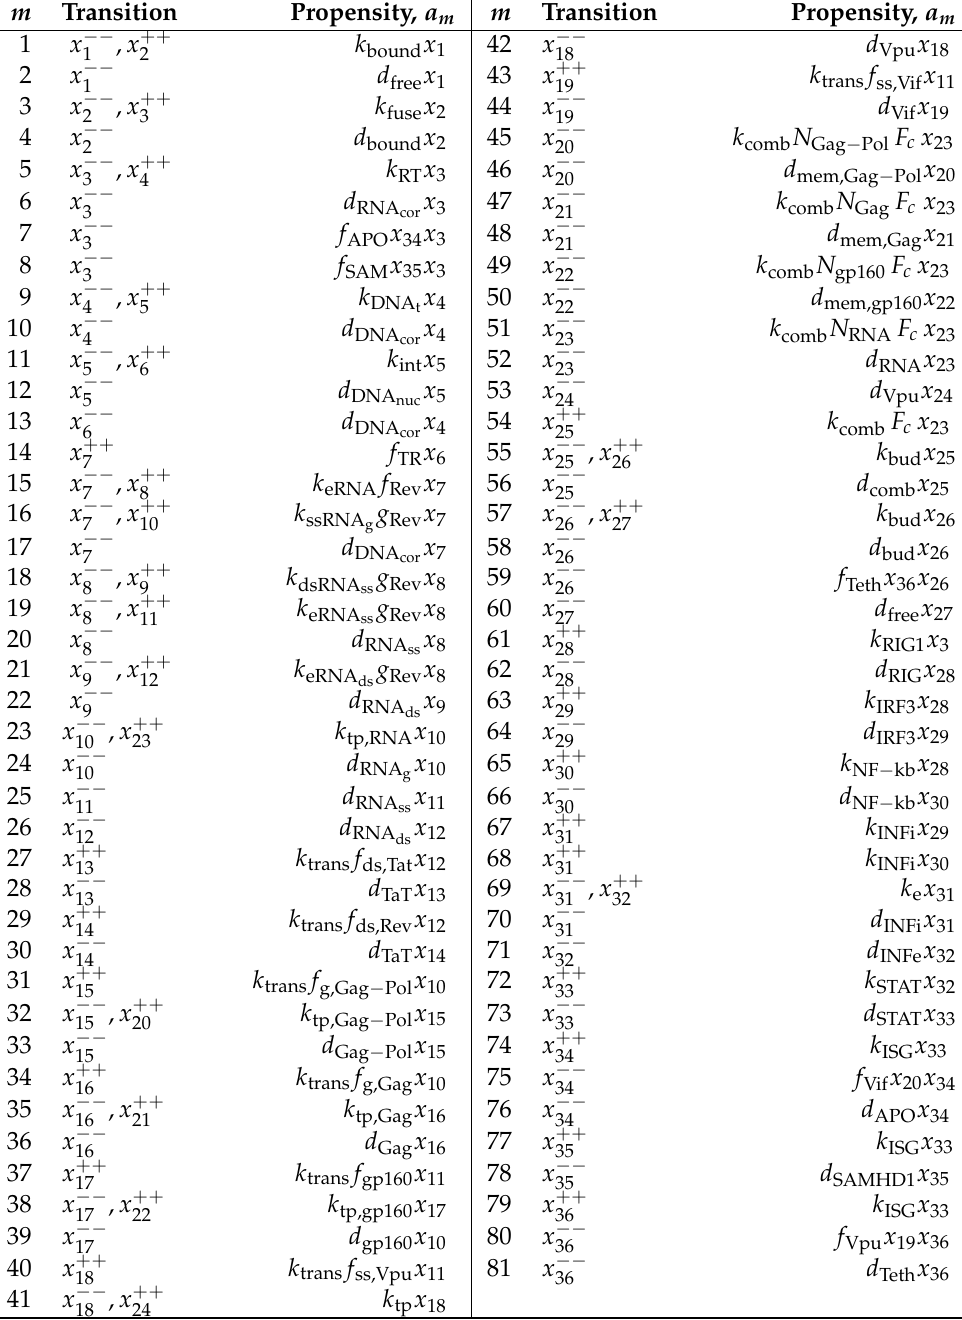
Table 1. The Markov chain. Symbols x −− n and x ++ n denote, respectively, the decrease and increase in abundance of component x n by one particle during the m th